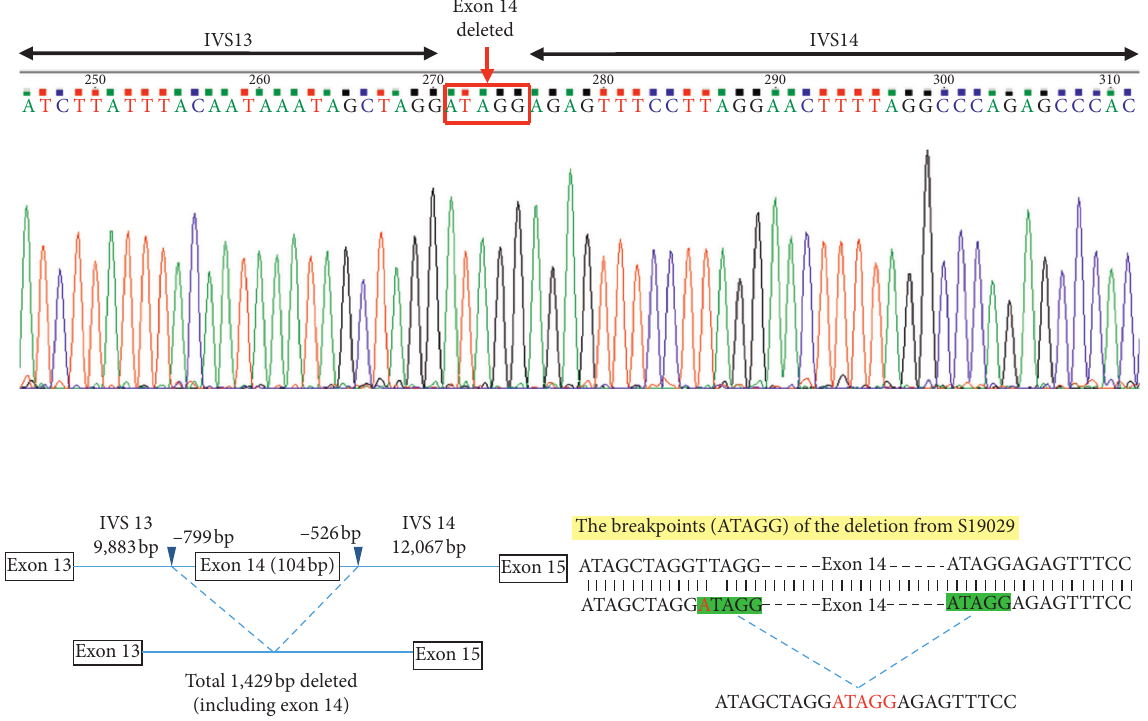
Figure 6: PHEX gene deletion around exon 14 and the breakpoint (ATAGG) of the